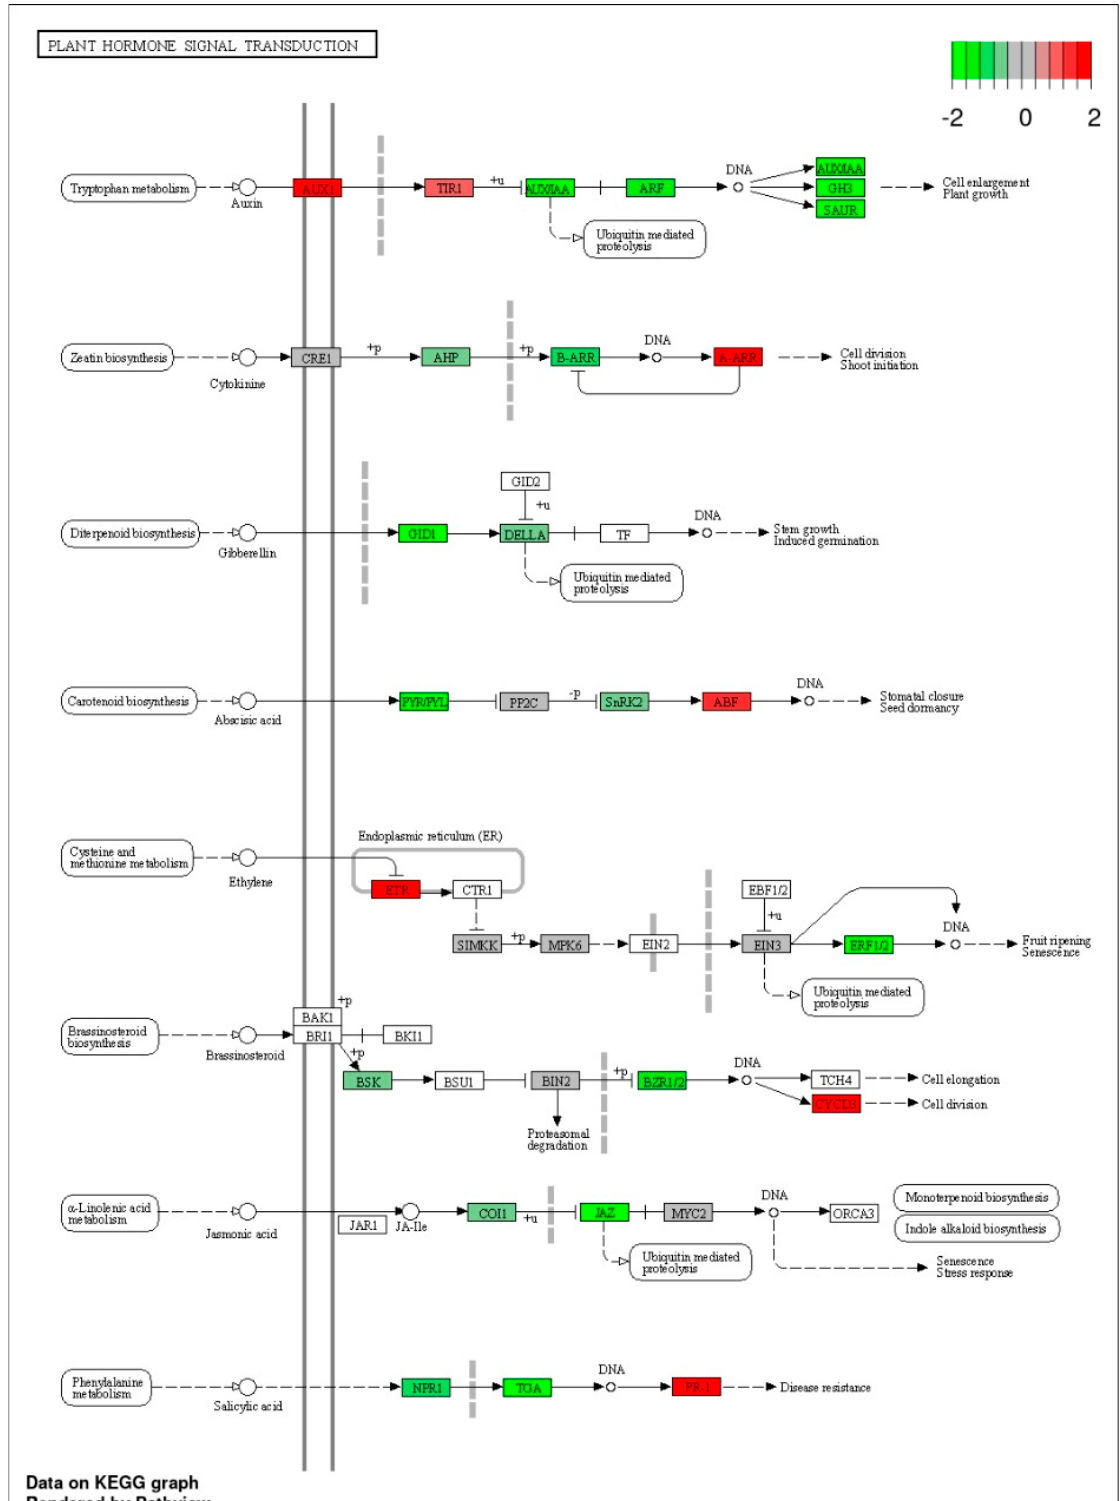
Figure 8. Expression profile of hormonal signaling-pathway-related genes visualized on KEGG Pathway using “Pathview”. The proteins marked green were down-regulated, while that of red were up-regulated under salt stress conditions in the salt-sensitive canola cultivar Oscar.